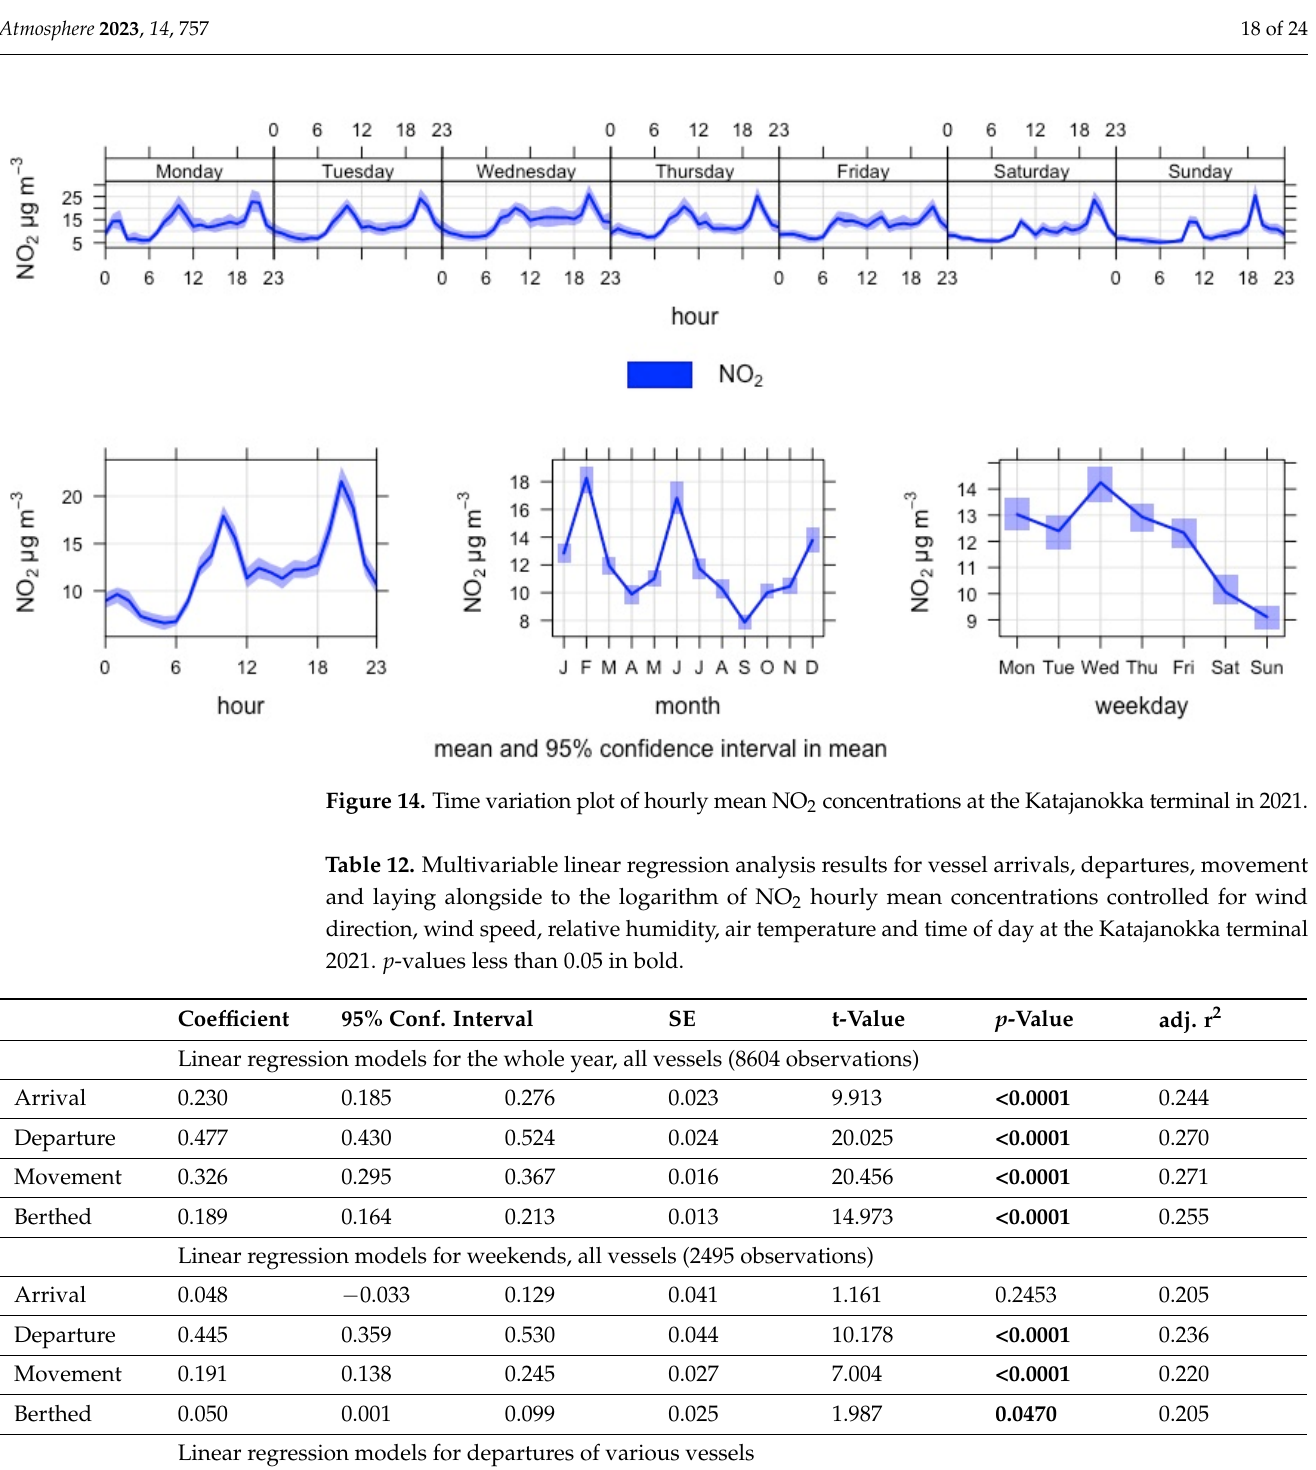
Table 12. Multivariable linear regression analysis results for vessel arrivals, departures, movement and laying alongside to the logarithm of NO 2 hourly mean concentrations controlled for wind di- rection, wind speed, relative humidity, air temperature and time of day at the Katajanokka terminal 2021. p -values less than 0.05 in bold.